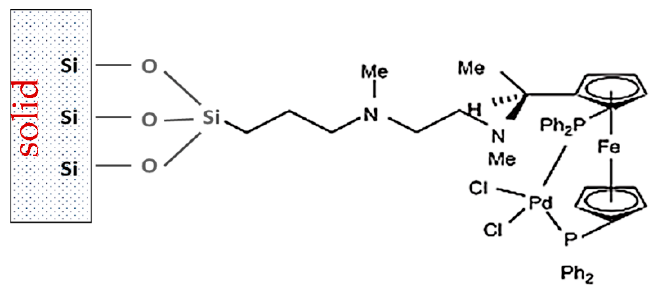
Figure 21. Amination catalysts used in allylic amination of cinnamyl acetate with benzylamine. Adapted from [130].